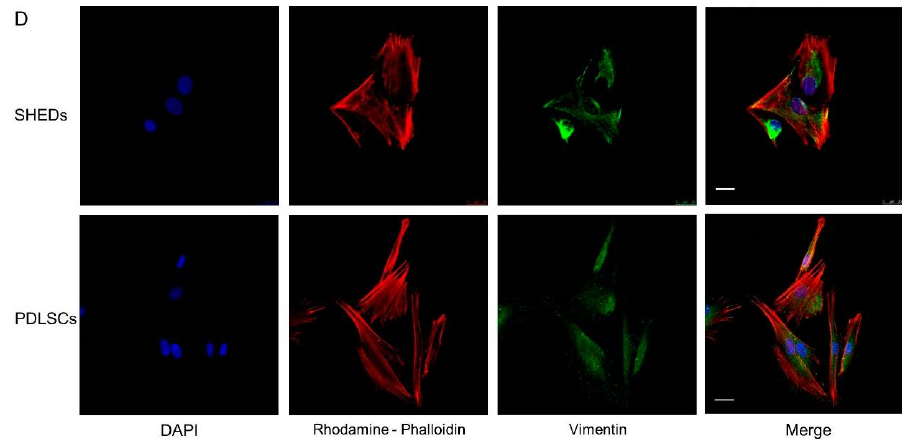
Figure 1. Cellular topology and distribution of the SHED-PDLSC “consensus” proteome generated via nano-LC-MS/MS employment and microscopic visualization of highly abundant cytoskeletal proteins. ( A ) Clustering of the identified, by nano-LC-MS/MS technology, proteins that were expressed in both SHEDs and PDLSCs (“consensus” proteome), into groups based on their cellular topology and distribution (“Cellular Component”). The Gene Ontology (GO) sub-routine of DAVID program was the bioinformatics protocol applied. p < 0.05. ( B – D ) Representative immunofluorescence images of SHEDs and PDLSCs, captured by confocal microscopy, demonstrating the expression of cytoskeletal proteins. ( B ) a-Tubulin revealed the characteristic spindle-like morphology and filamentous intracellular organization of microtubules cytoskeleton. ( C ) α actinin-4 is found along microfilament bundles and adherent junctions. ( D ) Vimentin is the major cytoskeletal component of mesenchymal cells. Blue: DAPI (nuclear staining). Green: antibodies for tubulin, actinin or vimentin. Red: phalloidin. Magnification: 63×.